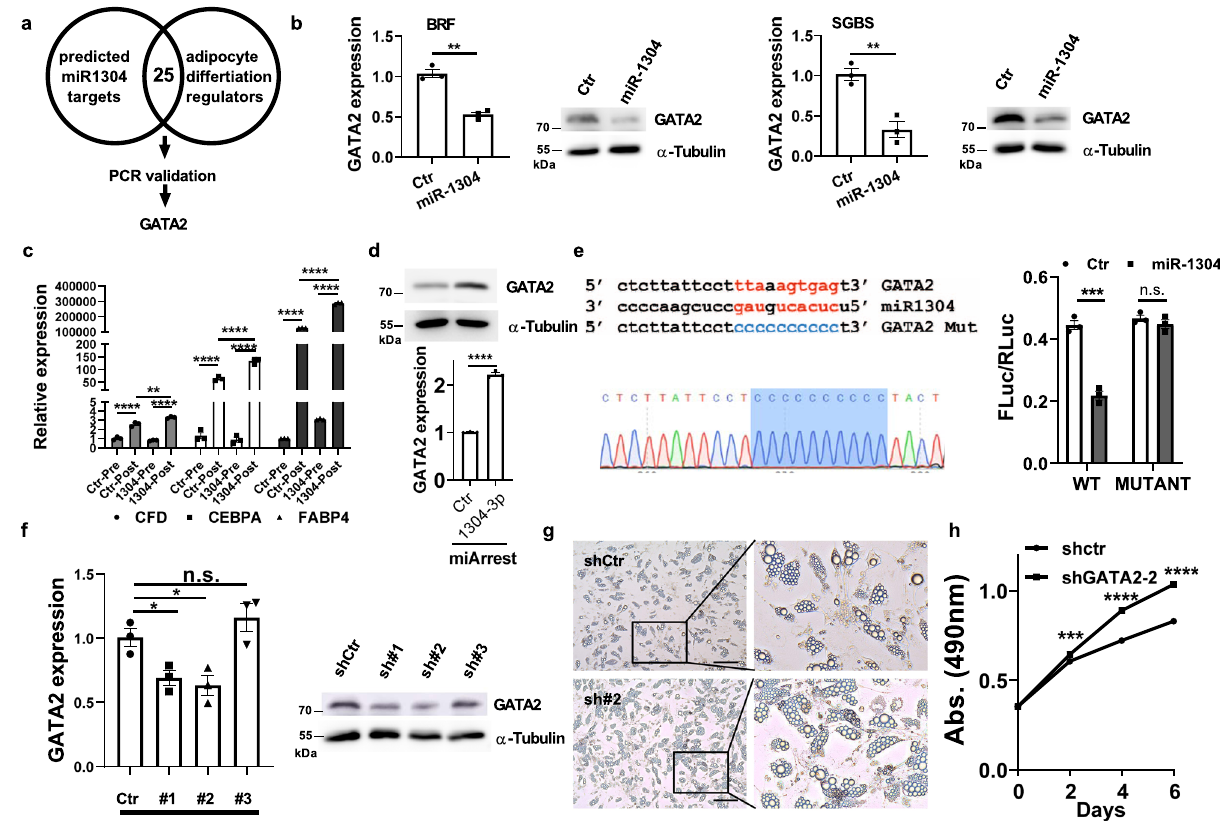
Fig. 5 | miR-1304-3p inhibits GATA2. a Genes in the GO term GO0045599 “ Negative regulator of fat cell differentiation ” were examined for miR-1304-3p bindingin3 ’ -UTRbymiRWalk. b GATA2wasexaminedbyRT-PCR(left)andwestern blot(right)inprimaryadipocytesafterectopicexpressionofmiR-1304( n =0.5x10